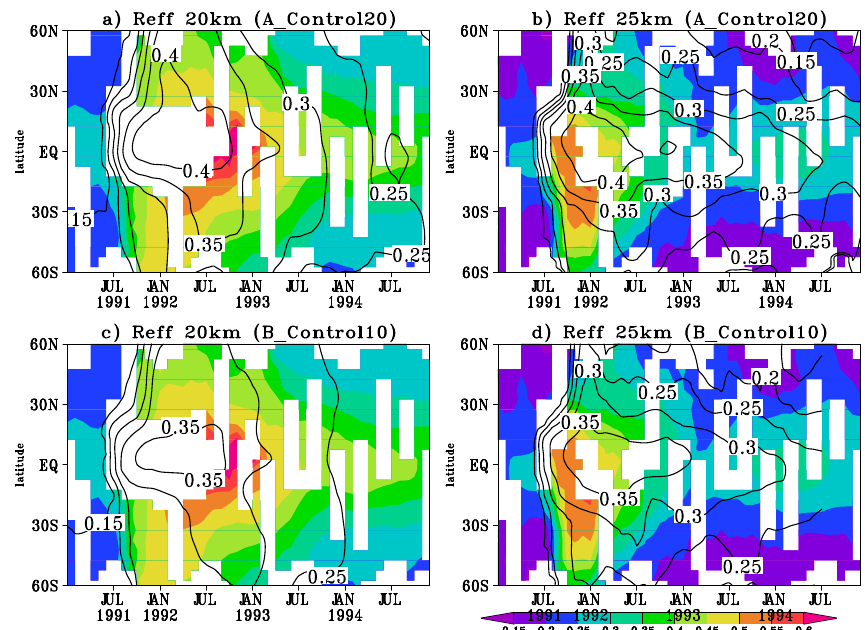
Figure 8. Satellite-derived (shaded, from Bauman et al., 2003) and modelled (contours) effective radii ( R eff ) in µm at 25 and 20km from runs A_Control20 (panels a and b) and B_Control10 (panels c and